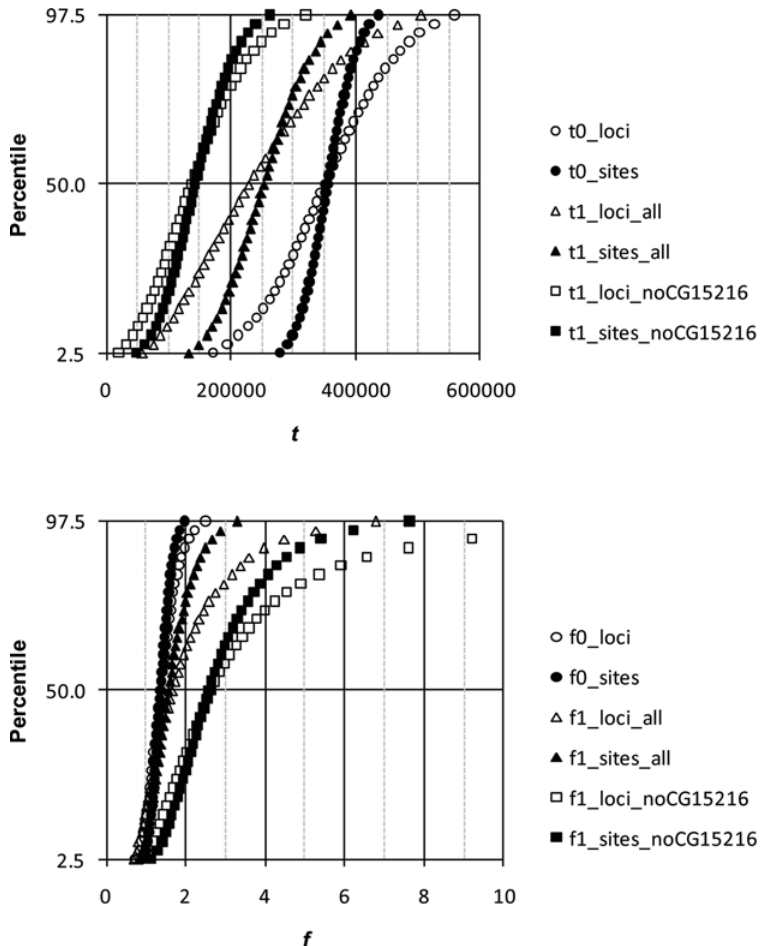
Figure 1. Distribution of parameters estimated from 10,000 bootstrapped data sets using the 2-parameter model for D.simulans and D.mauritiana . Shown are distributions using hˆ p as the estimate of D. simulans polymorphism. Suffixes in legend: loci, bootstrapping among both loci and of sites within loci; sites, bootstrapping of sites, but not loci; all, all LR loci; noCG15216, CG15216 excluded from LR loci.